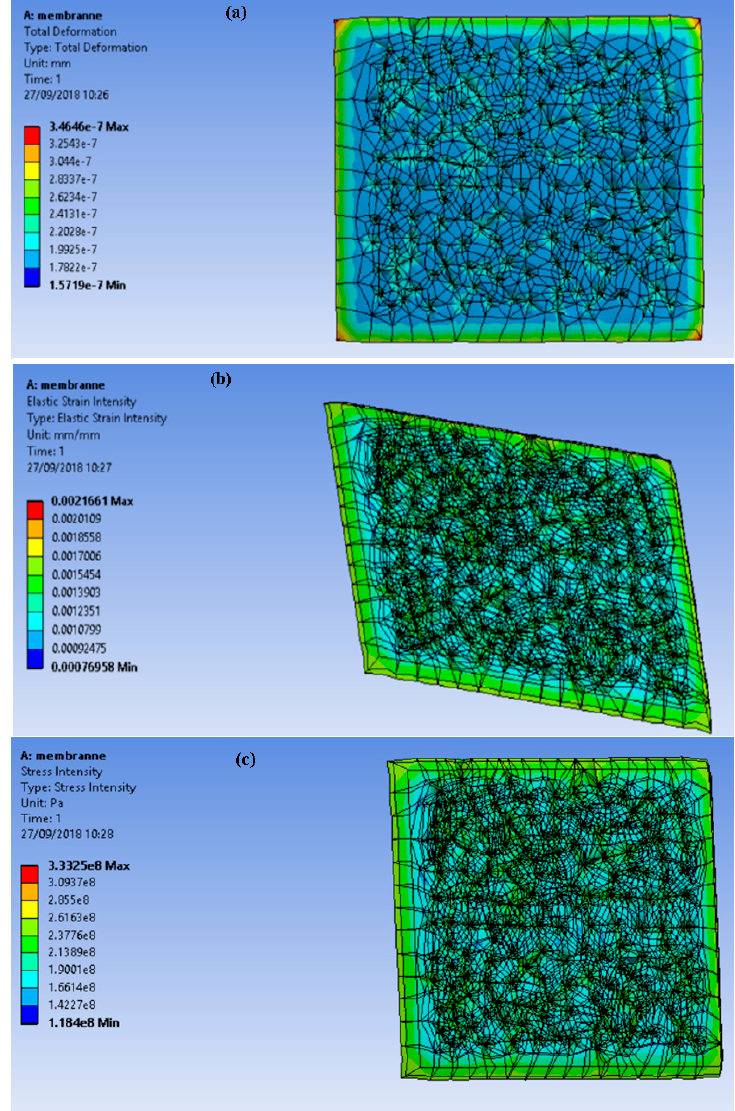
Figure 3. ( a ) Total deformation; ( b ) strain intensity; ( c ) stress intensity.